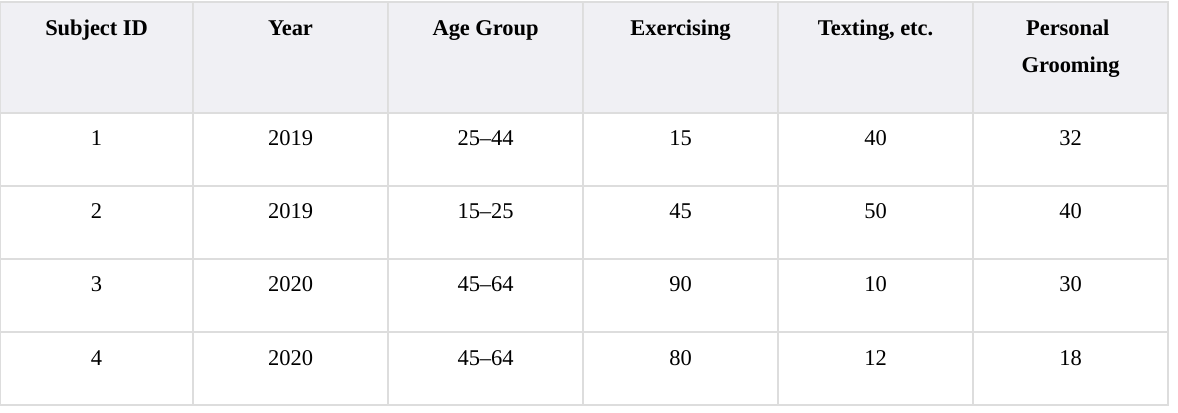
Table 2. Sample data structure in spreadsheet